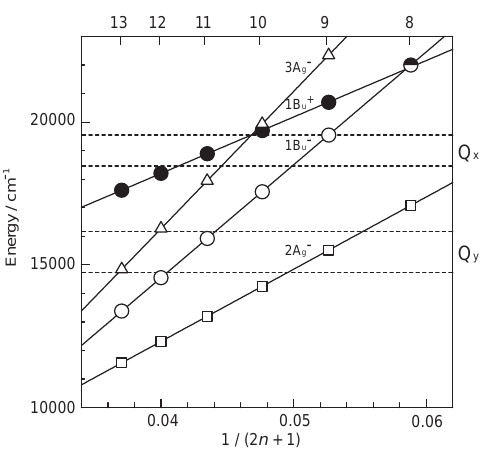
Figure 23. The energies of the optically-allowed 1B u+ and the optically-forbidden 2A g– , 1B u– and 3A g– states of Car and those of the Q chain Cars ( n = 8 and 9) have a better chance of singlet-energy transfer to Phe a .